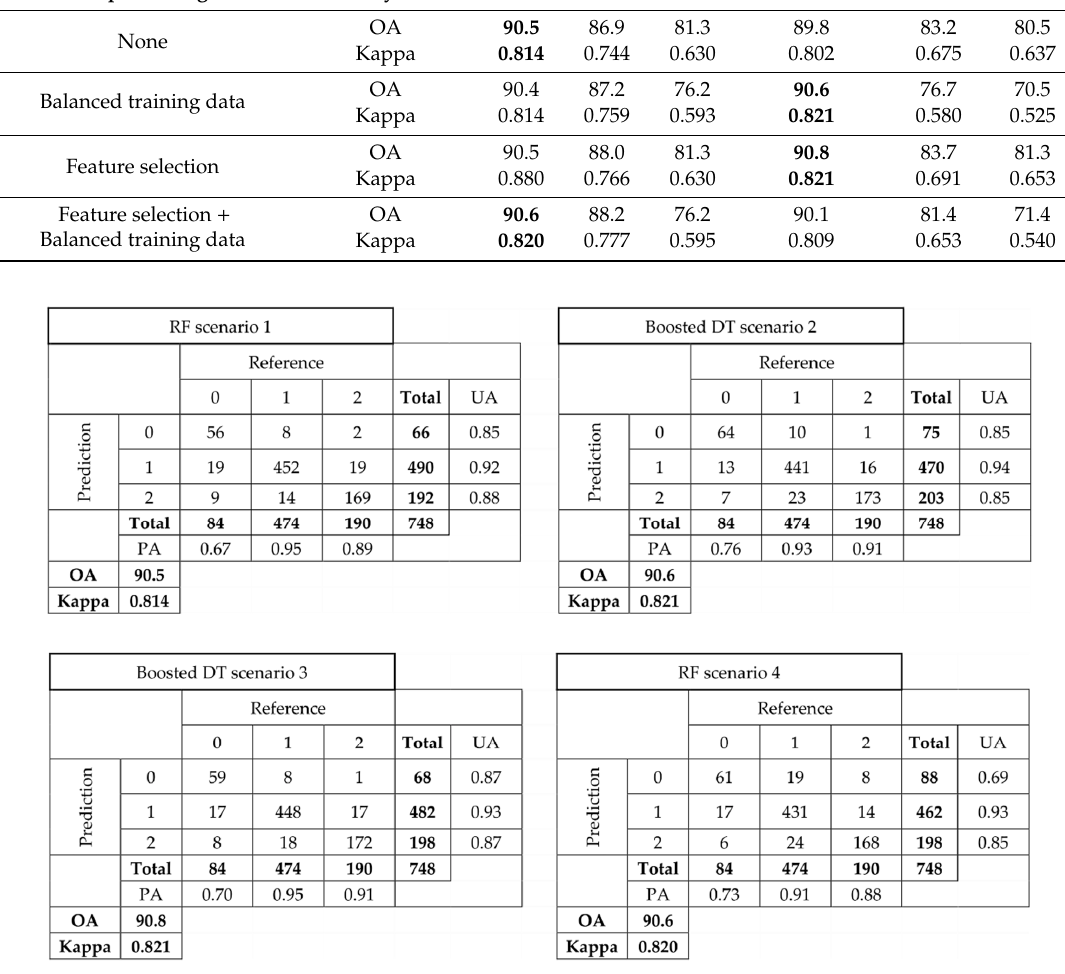
Figure 12. Confusion matrix, OA (%), PA, UA, Kappa statistic, McNemar’s test P-value, and CI for the best model associated with each scenario identified in Table 8. RF scenario 1: CI = (0.882, 0.925), McNemar's Test P-Value = 0.021; Boosted DT scenario 2: CI = (0.883, 0.926), McNemar's Test P-Value = 0.105; Boosted DT scenario 3: CI = (0.885, 0.923), McNemar's Test P-Value = 0.03336; RF scenario 4: CI = (0.861, 0.889), McNemar's Test P-Value = 0.434.